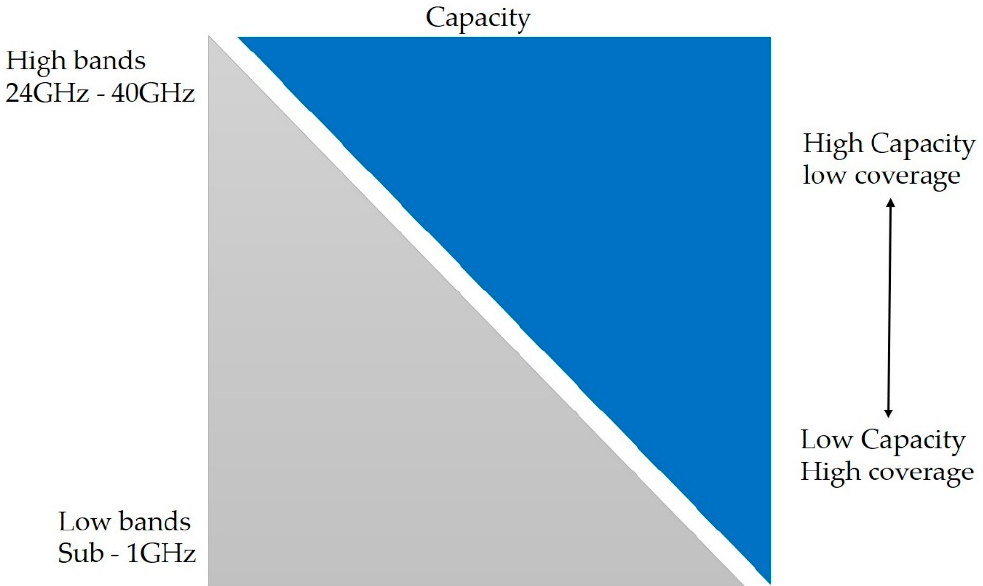
Figure 2. Coverage and capacity characteristics of 5G radio frequency ranges.